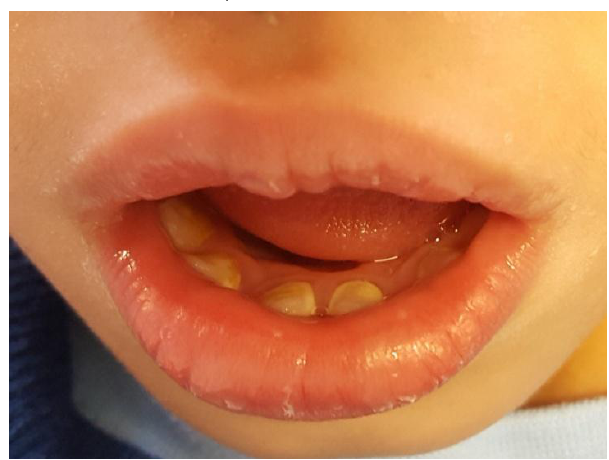
Figure 1 : Tartar in the lower incisors in first-phase mixed dentition with deciduous teeth cohabiting with the first permanent molar.